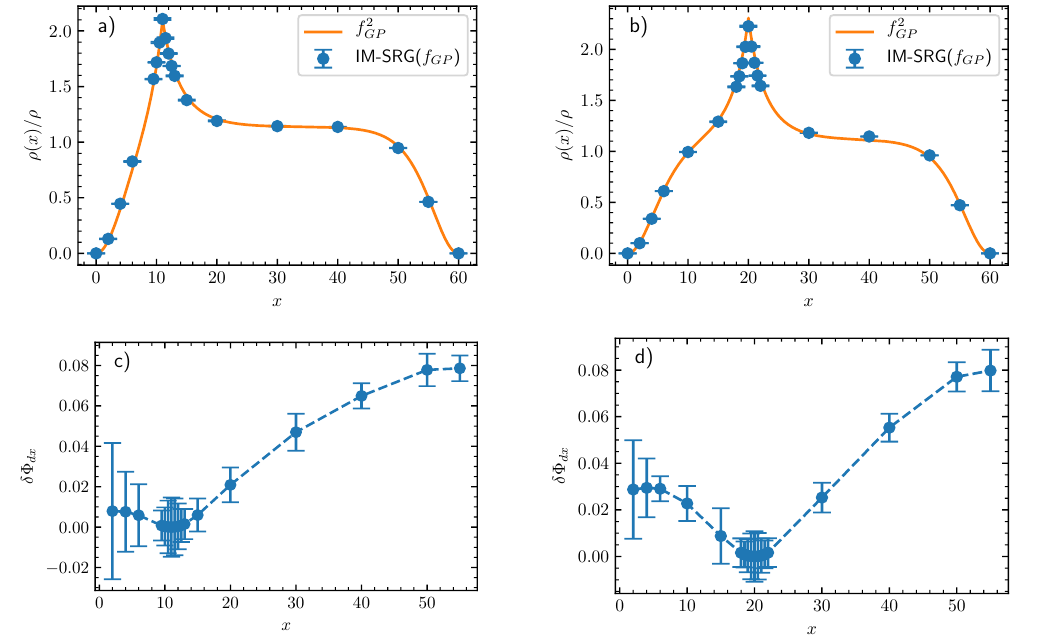
= − 0.1 Figure 11: (Upper Row): The density of the Bose gas for N = 60, γ = 0.02, c 2 and two different separations of the impurities: a) d = 11 and b) d = 20. We show the density calculated using flow equations (dots) together with the density calcu- lated using the reference state, f (solid curve). (Bottom Row): Phase fluctuations GP = − 0.1 and the separations c) d = 11 and of the Bose gas for N = 60, γ = 0.02, c 2 d) d = 20. The dots show the IM-SRG( f ) results. The dashed curves are added to GP guide the